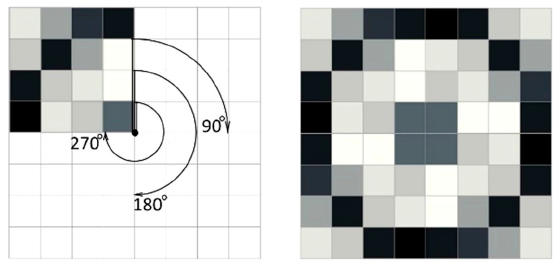
Figure 10. Basic structure and cells of periodicity Y C exhibiting homogenized exact cubic symmetry properties of a periodic body.